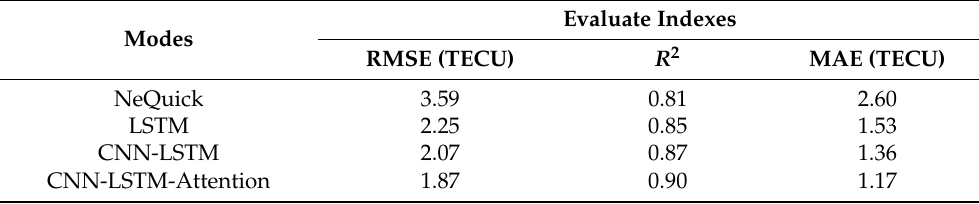
Figure 6. Histogram for RMSE and R 2 of NeQuick (blue), LSTM (yellow), CNN-LSTM (green), and CNN-LSTM-Attention (red) models from 12 stations in the test set. ( a , b ) are RMSE. ( c , d ) are R 2 . Table 3. The overall evaluation indexes of four models in 24 stations in the test